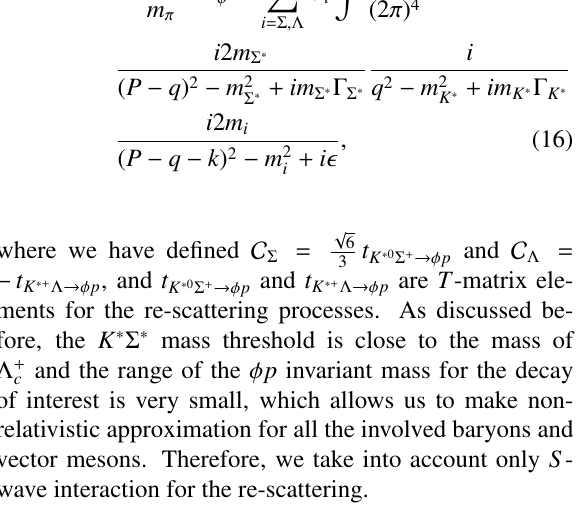
→ Σ ∗ 0 (1385) K ∗ + . ( B ): Λ + c